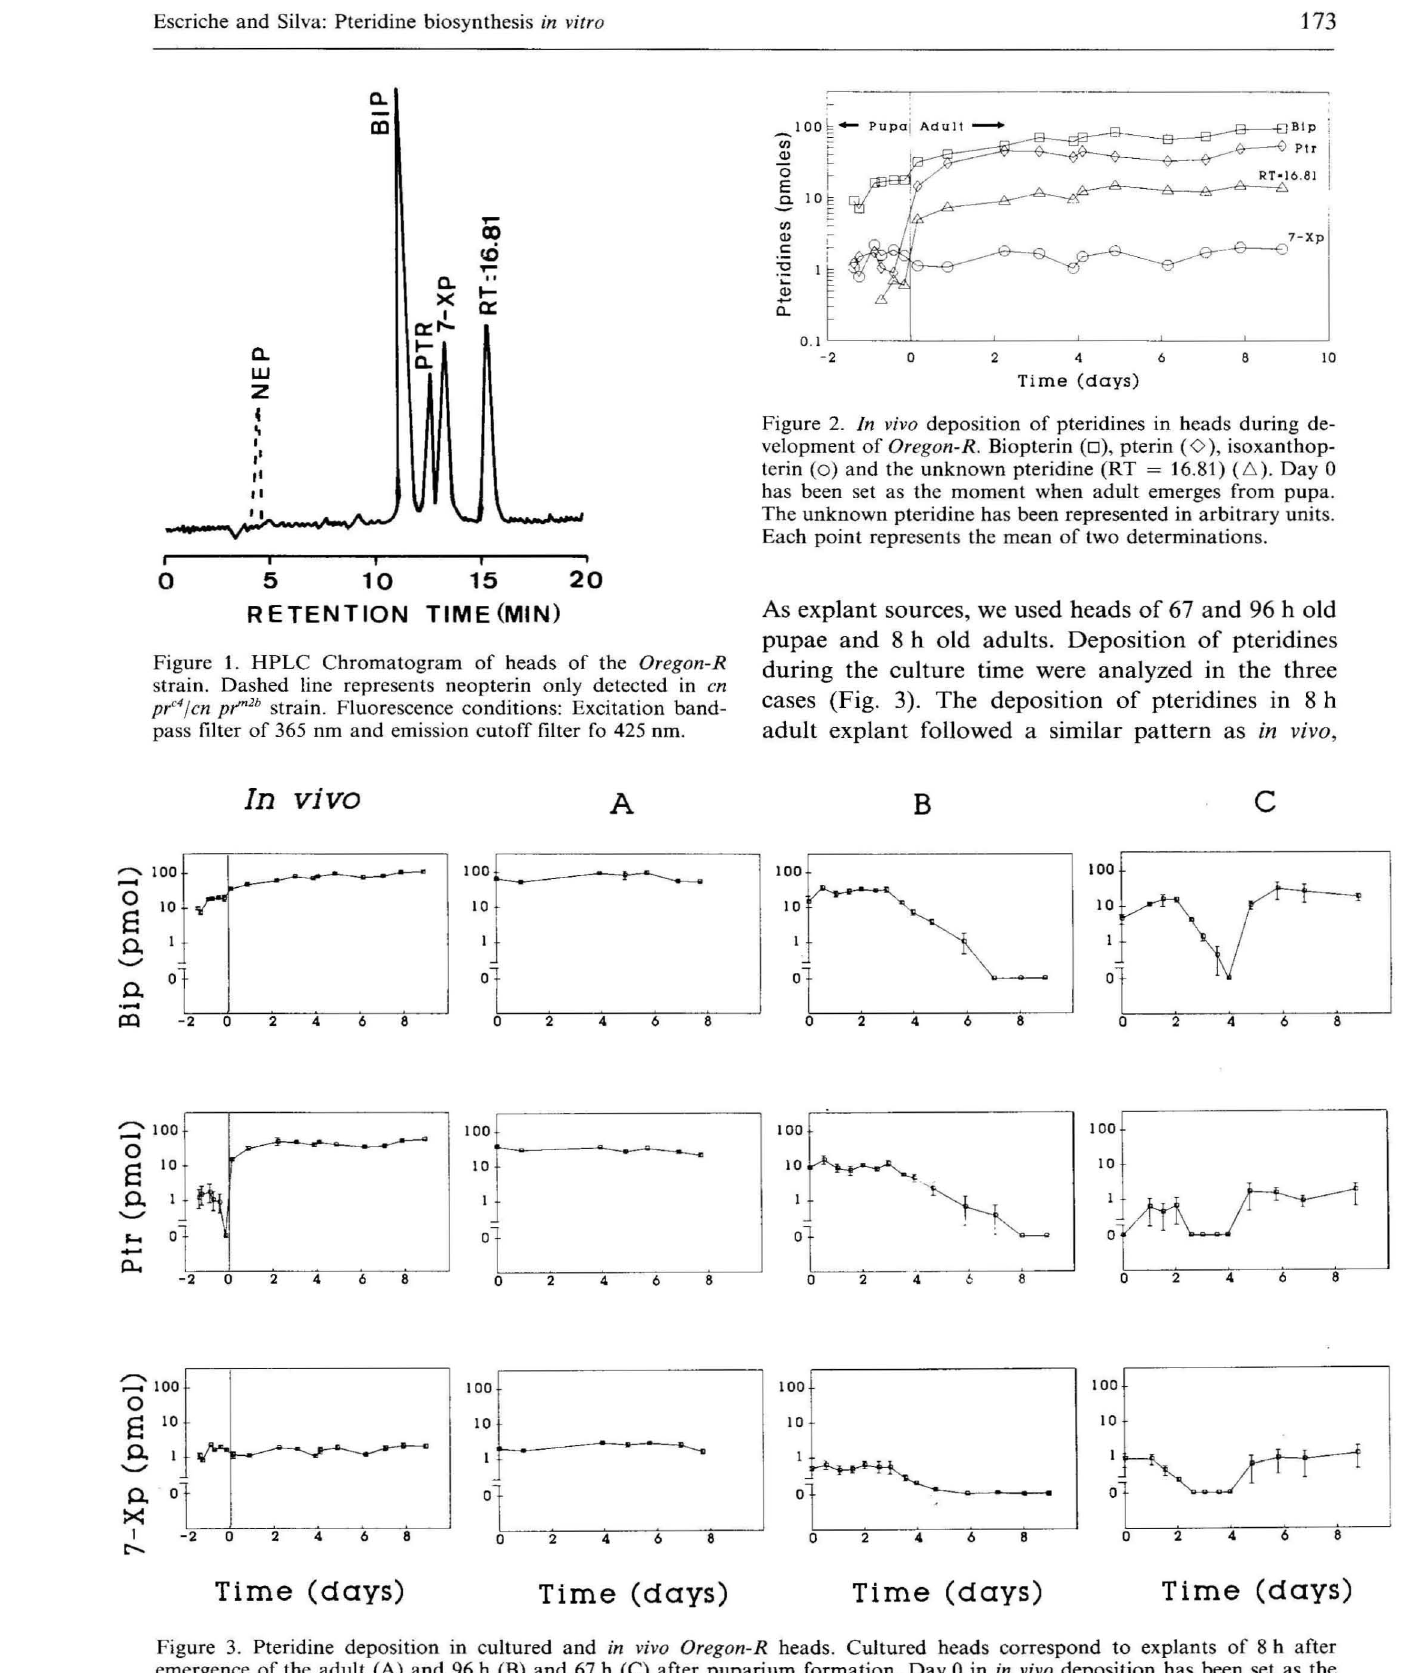
Figure 3. Pteridine deposition in cultured and in vivo Oregon-R heads. Cultured heads correspond to explants of 8 h after emergence of the adult (A) and 96 h (B) and 67 h (C) after puparium formation. Day 0 in in vivo deposition has been set as the moment when adult emerges from pupa. In cultured heads day 0 refers to the moment when culture was started. Each point represents the mean of two to three determinations and bars are standard errors of means.